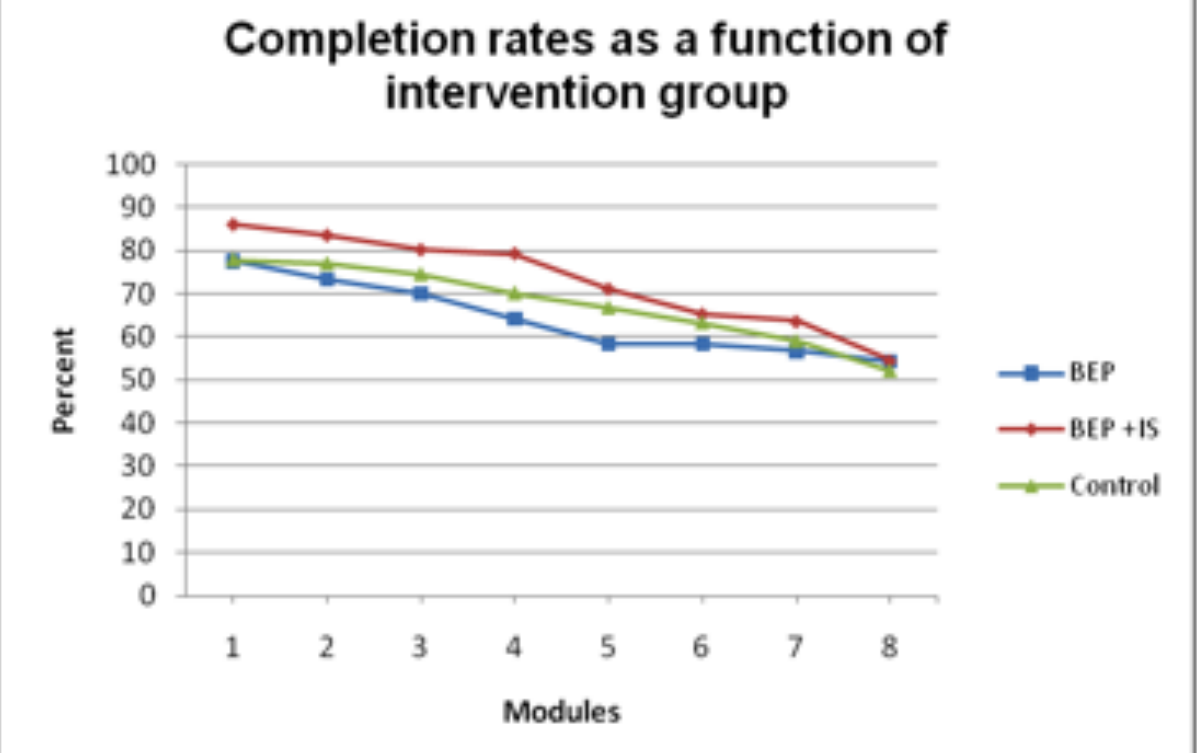
Figure 2. Completion rates for each of the 8 modules by intervention group: Bipolar Education Program (BEP); Bipolar Education Program with email support from informed supporters (BEP + IS); and minimal information about bipolar disorder (control)